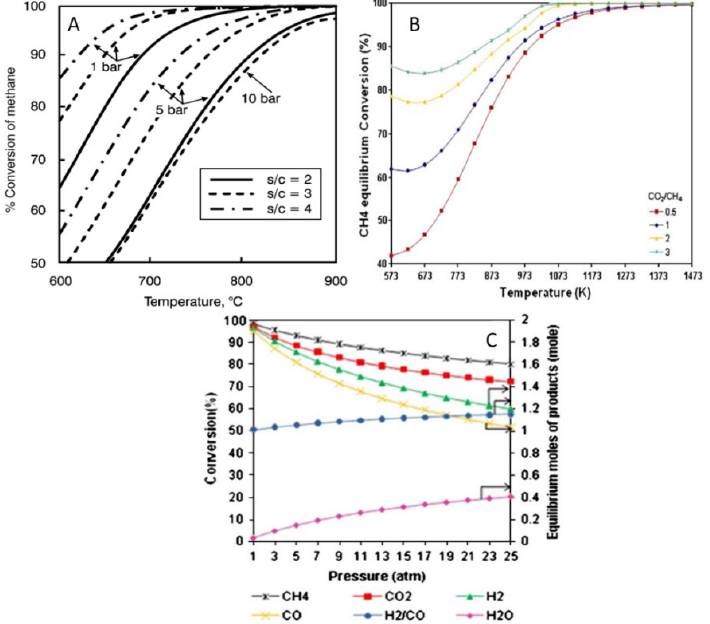
Figure 1. Equilibrium conversion of ( A ) SMR against temperature, pressure, and steam/methane ratio. Reprinted with permission from [9], copyright 2022, Elsevier. ( B ) DRM against temperature and CO 2 /CH 4 ratio ( C ) DMR against reactants and products distribution for CO 2 /CH 4 = 1, 900 °C and n (CH 4 + CO 2 ) = 2 mol. Reprinted with permission from [13], copyright 2011, Elsevier. Like SMR, the DRM process is highly endothermic and as such is favored at high temperatures (700–900 °C). As CO 2 is one of the reactants, this type of methane reforming